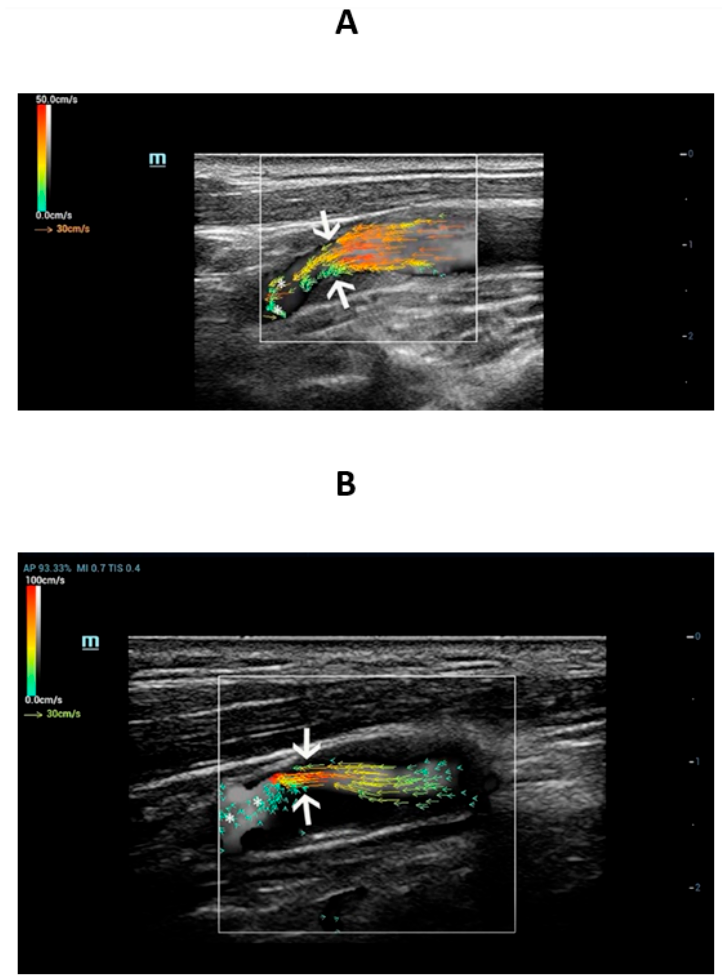
Figure 1. High-frame-rate vector flow imaging of the carotid stenosis. Moderate stenosis of the right internal carotid artery (61, male) ( A ) and severe stenosis of the left internal carotid artery (67, male) ( B ). The vector arrows at the stenosis (arrow) site became longer and the color of the vector arrow was red. V Flow could intuitively show changes of flow velocity at the carotid stenosis site. Complex blood flow such as vortex (short green or yellow vectors) (asterisk) could be detected at the distal area of the stenosis.